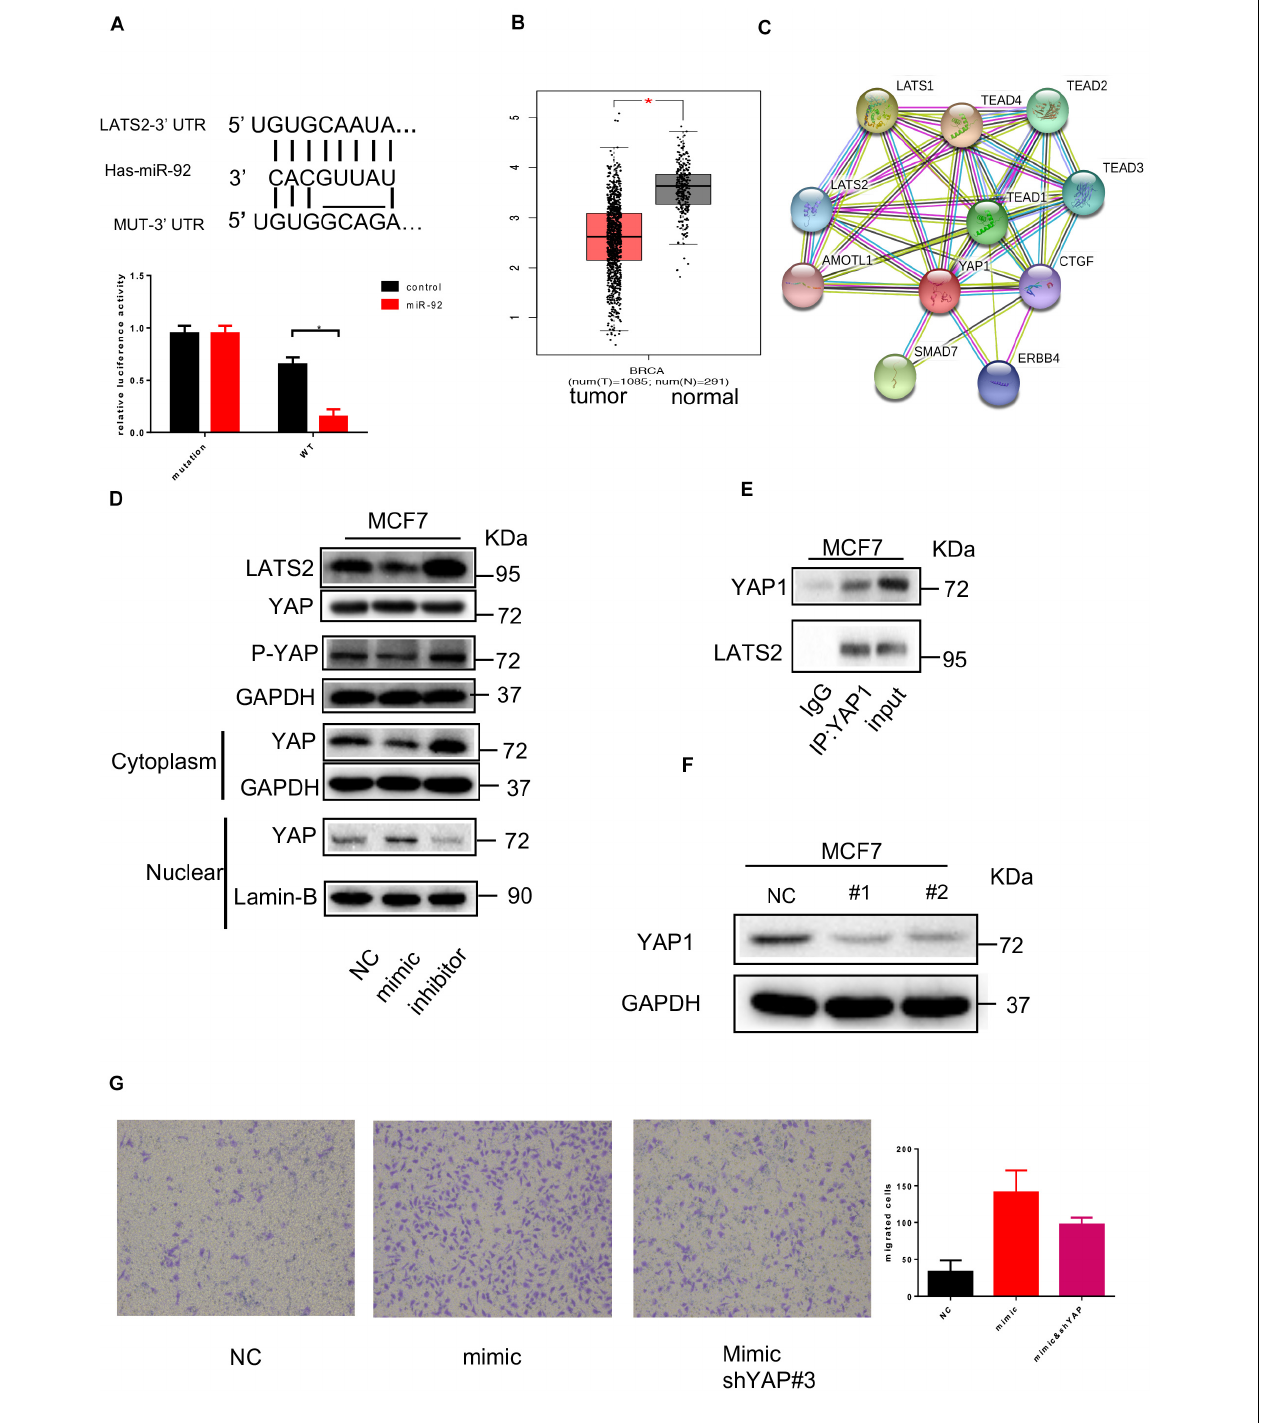
FIGURE 3 | miR-92 targeting LATS2 and enhance nuclear translocation of YAP1. (A) Schematic representation of the miR-92 targeting sequences within the 3 (cid:48) UTR of LATS2. A luciferase reporter assay was conducted in MCF7 cells following transfection with the miR-92 mimic or NC, and together with WT or Mut LATS2 3 (cid:48) UTR luciferase reporter plasmid. (B) LATS2 expression was examined in normal and breast cancer tissue from a public dataset. (C) The protein–protein network view from the STRING database showing the networks of LATS2. (D) Western blot shows the YAP1, LATS2 expression in MCF7 which transfected with the miR-92 mimic or inhibitor. (E) Co-IP analysis with anti-YAP1 antibody or IgG in MCF7. (F) Western blot analysis of YAP expression after two shRNA target YAP was transfected. (G) Transwell assay for breast cancer cells which transfected with the miR-92 mimic and/or shRNA targeting YAP (magnification, × 100). Error bars represent mean ± SD; **** P < 0.0001; n.s., not significant; by paired two-sided Student’s t -test.